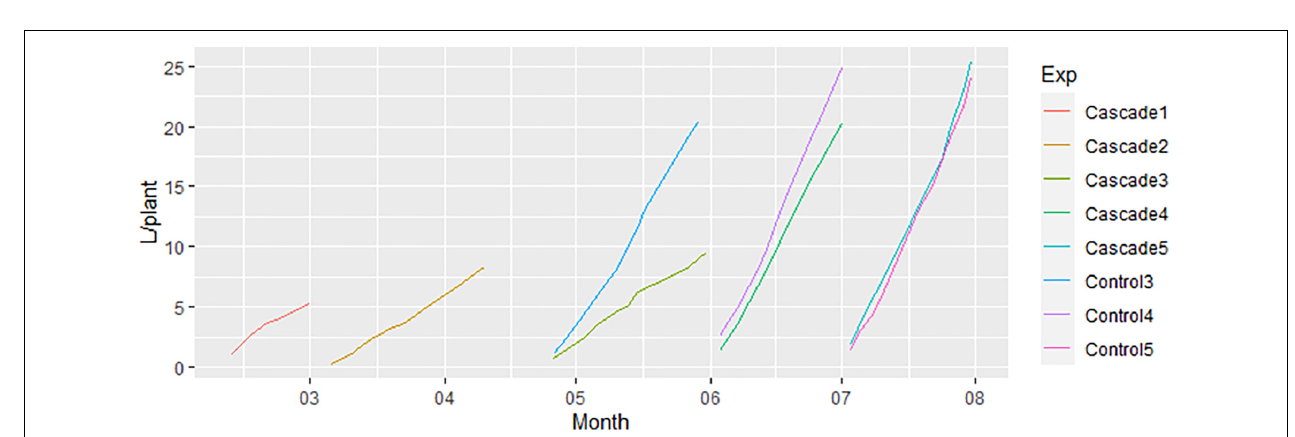
FIGURE 2 | Production of the different tests.